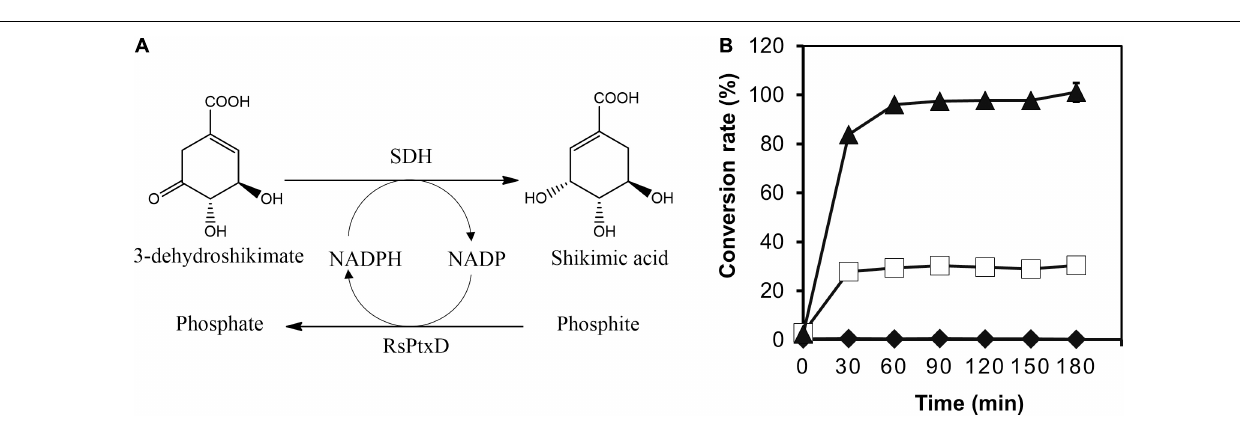
increasing amounts of substrate, 100 mM 3-DHS, could achieve 61 g L − 1 d − 1 productivity with a TTN of 860 for NADPH ( Supplementary Figure 3